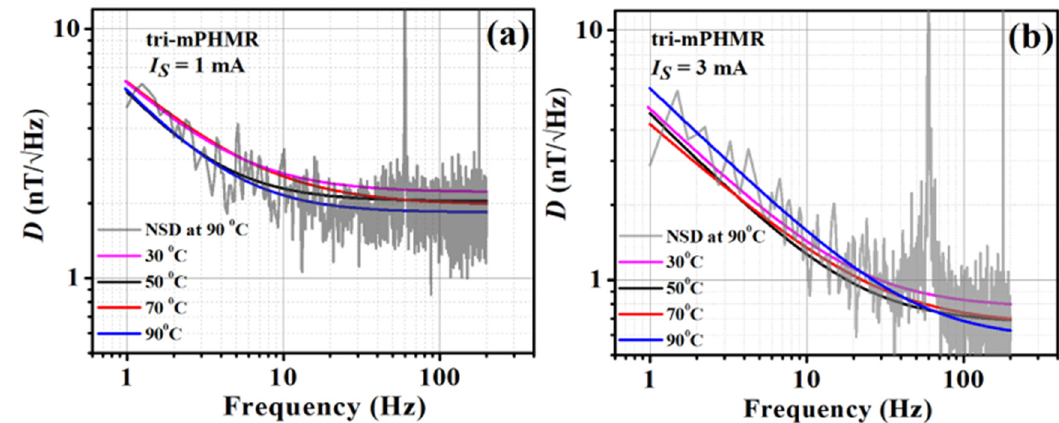
Figure 12. Detectivity plots at different temperatures and the fits employing Equation (14) at two different sensing currents: 1 mA ( a ) and 3 mA ( b ). Recorded NSD at 90 °C is shown in the background (gray).